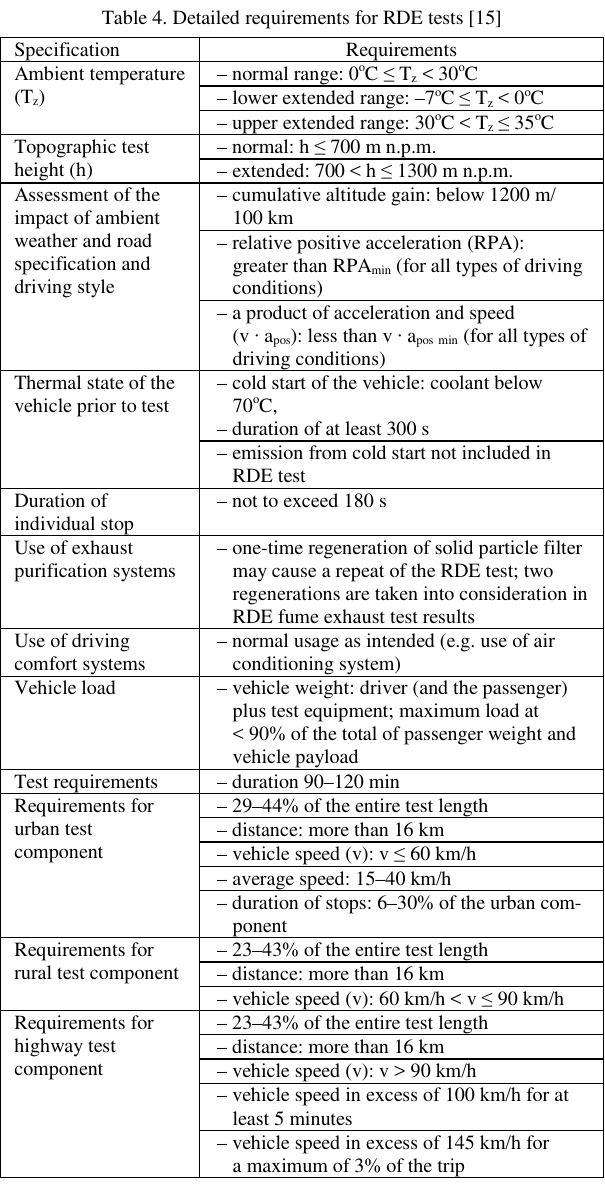
Table 4. Detailed requirements for RDE tests [15]